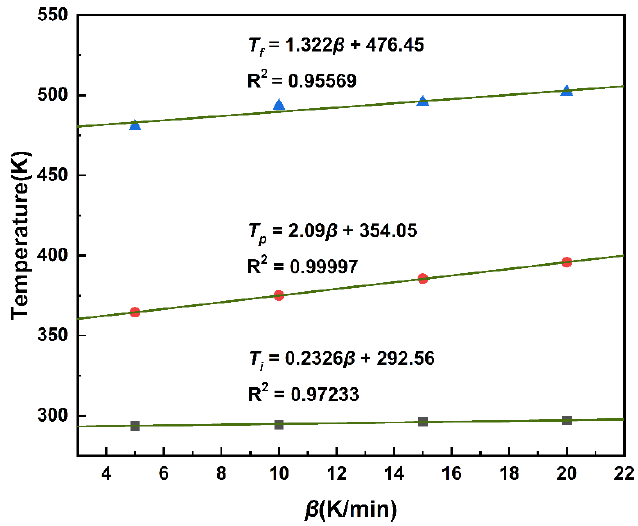
Figure 9. Characteristic curing temperatures.